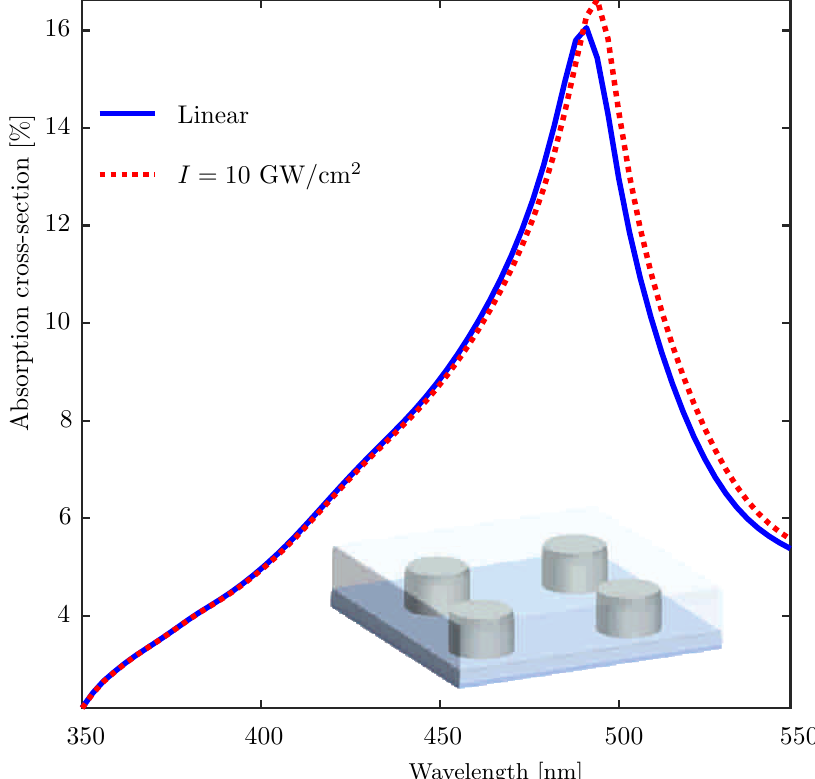
Figure 4. Power-dependent absorption cross-section spectra of a monolayer composite medium consisting of silver nanocylinders embedded in a polymer host medium calculated using the FMM- based approach. The host medium is assumed to possess only Kerr-type optical nonlinearity. The absorption spectra for the incident field intensity I = 10 GW/sq. cm, i.e., the dotted red curve shows enhancement and red-shift of the absorption spectrum as compared to the linear optical